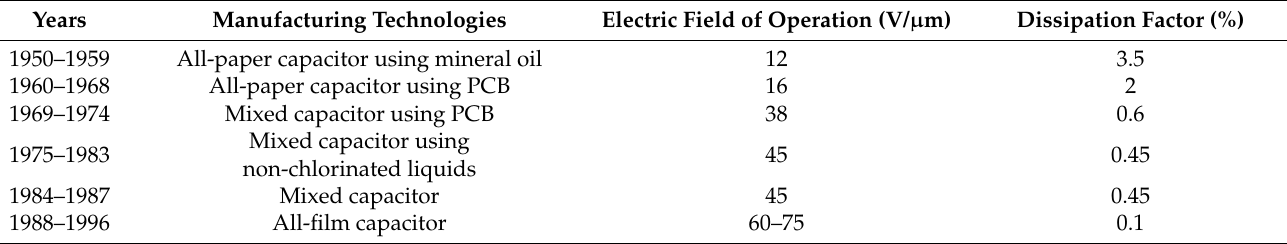
Table 1. Comparison of the electrical and dielectric characteristics of power capacitors from 1950 to 1996.